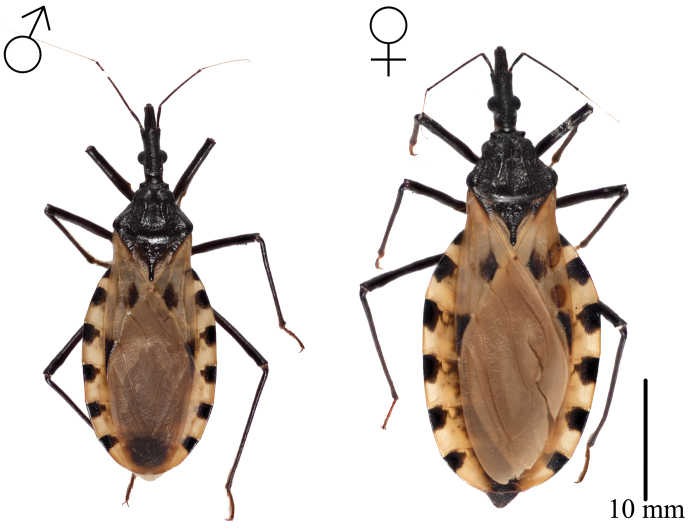
Overall vestiture of T.
mopan male and female. Scalebar 10 mm. Photographs Raquel Lima.